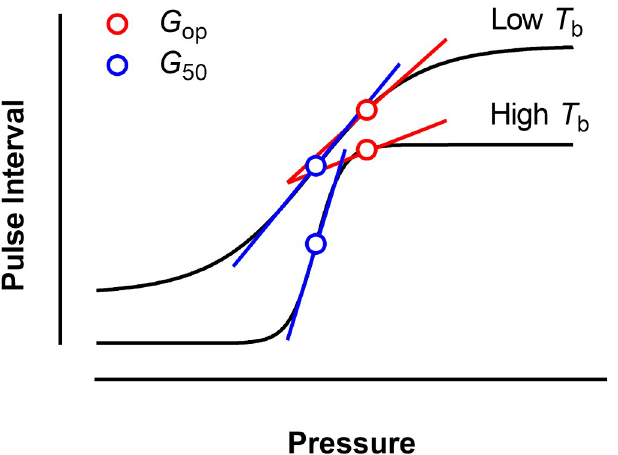
Fig 2. Schematic figure comparing baroreflex sensitivity assessed by two different methods. The sigmoidal baroreflex curves represent a theoretical response to body temperature ( T b ) changes. The sequence method estimates gain at the operating point ( G op ; red circle), whereas the pharmacological method estimates maximum gain ( G 50 ; blue circle). The slope at the specific point of the curves are in red for G op , and blue for G 50 . Note that, while the slope at G op is less inclined at higher T b , slope at G 50 is